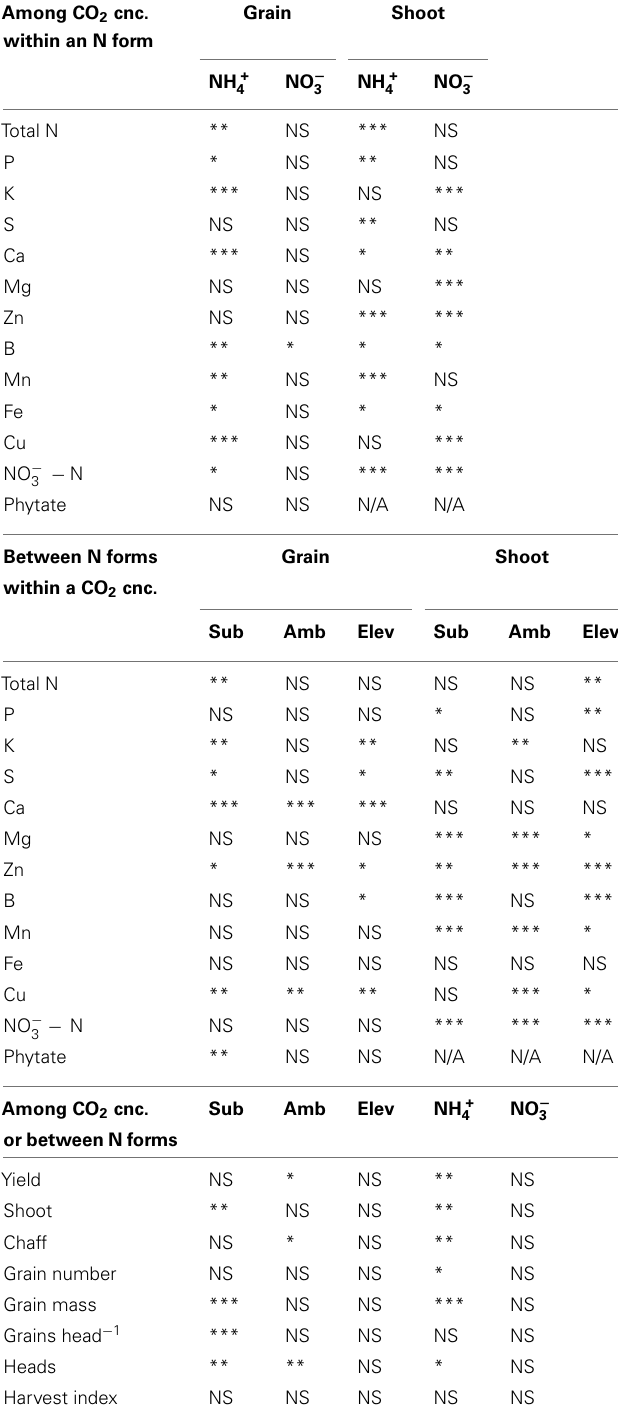
Table 1 | Results of a series of one-wayANOVAs run on the data. Among CO 2